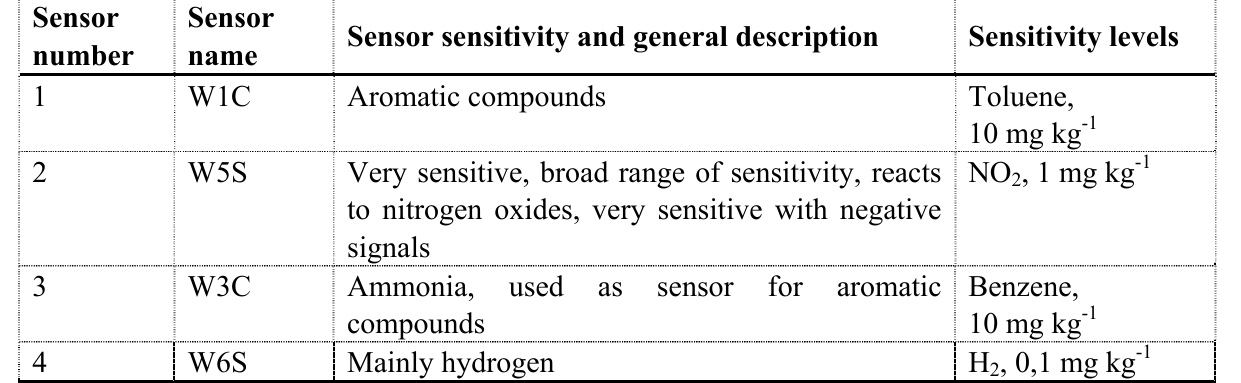
Table 3. Sensor sensitivity of individual sensors within the sensor array of the PEN3